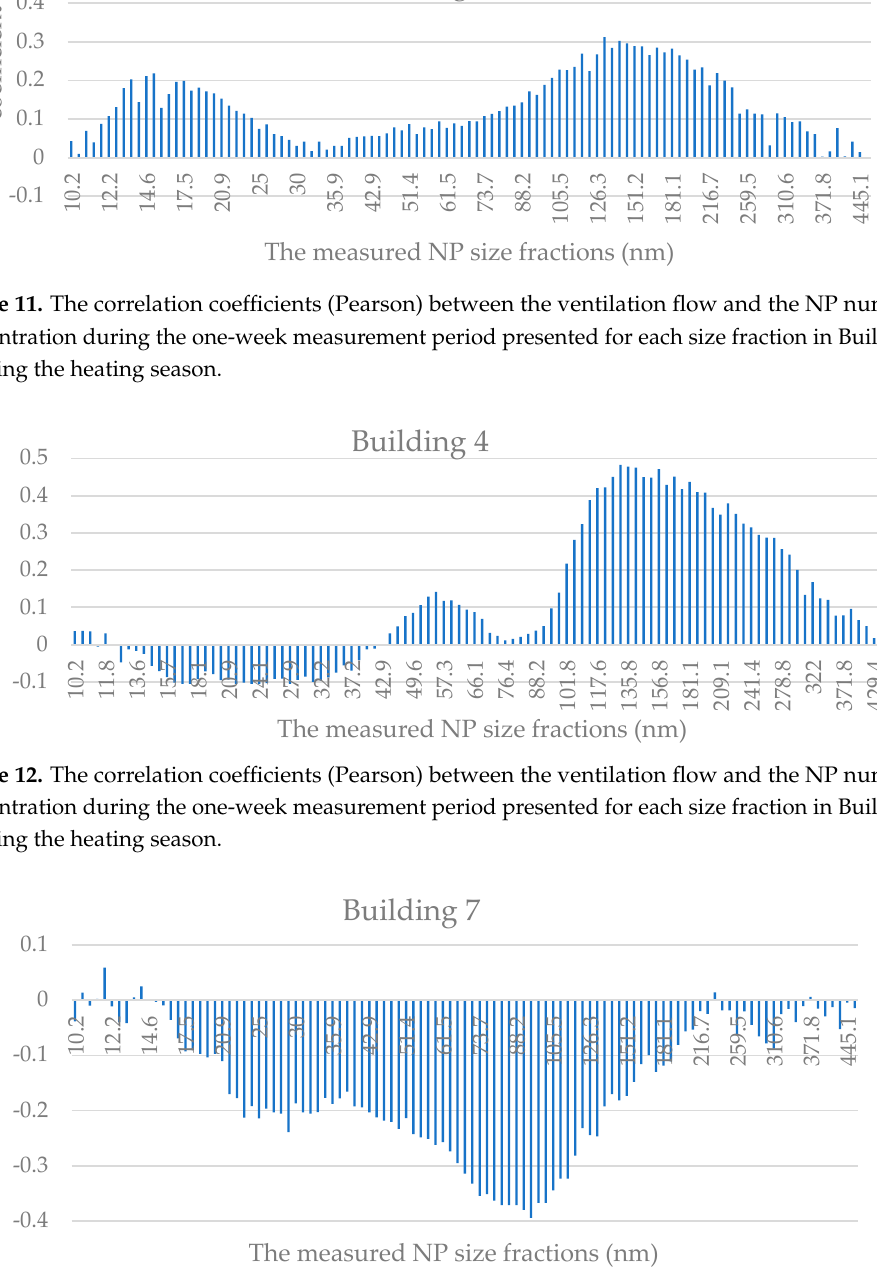
Figure 13. The correlation coefficients (Pearson) between the ventilation flow and the NP number concentration during the one-week measurement period presented for each size fraction in Building 7 during the heating season.